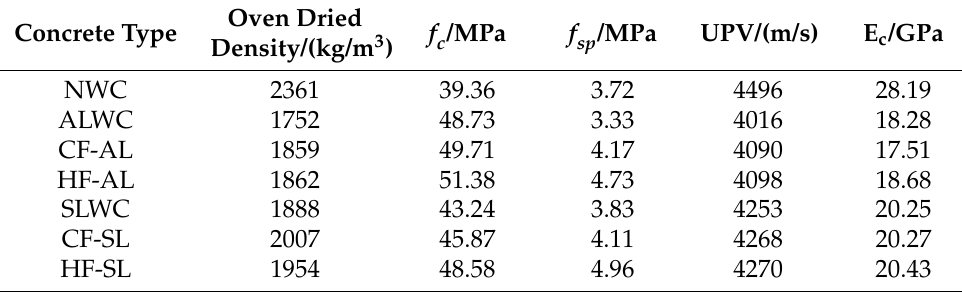
Table 5. Physical and mechanical characteristics of various mixtures at 28